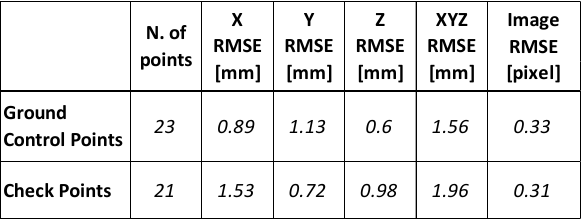
Table 1. Results of image orientation